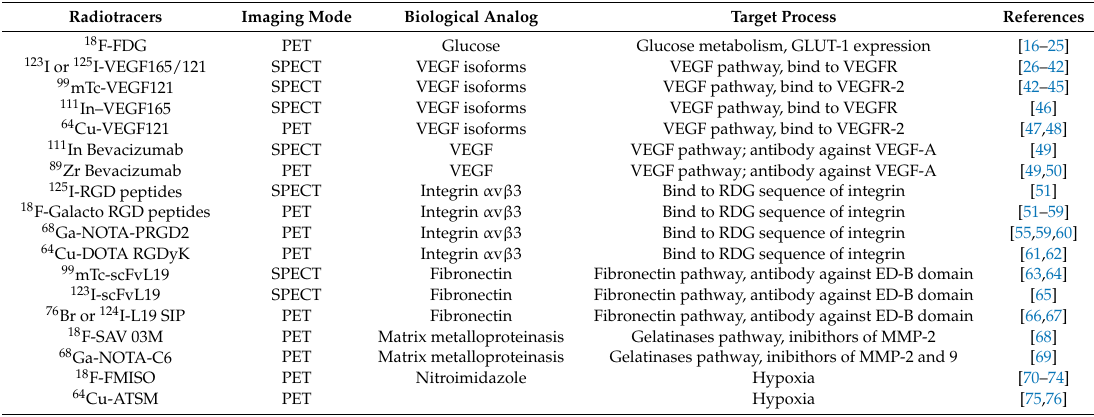
Table 1. Summary of radiopharmaceutical used for angiogenesis